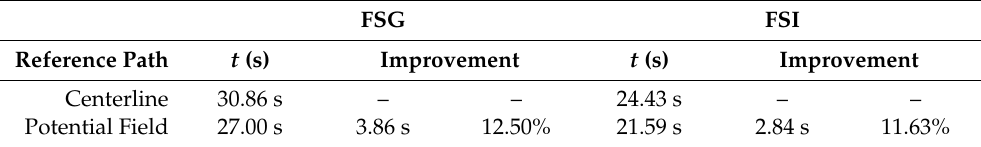
Table 3. Comparison between centerline and the potential field solution. FSG